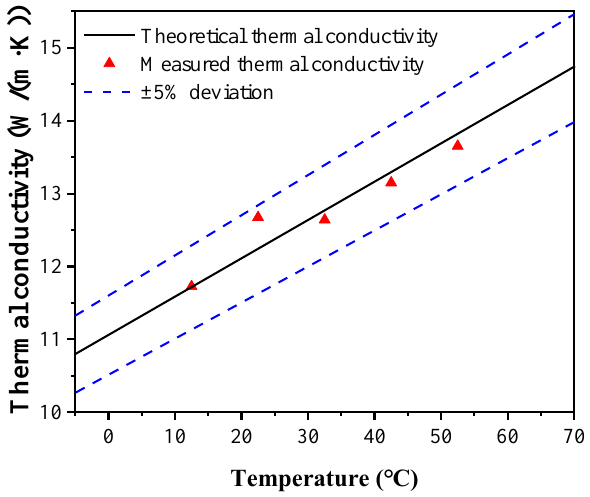
Figure 6. Comparisons between the experimental results and literature data [15] of 304 stainless steel.